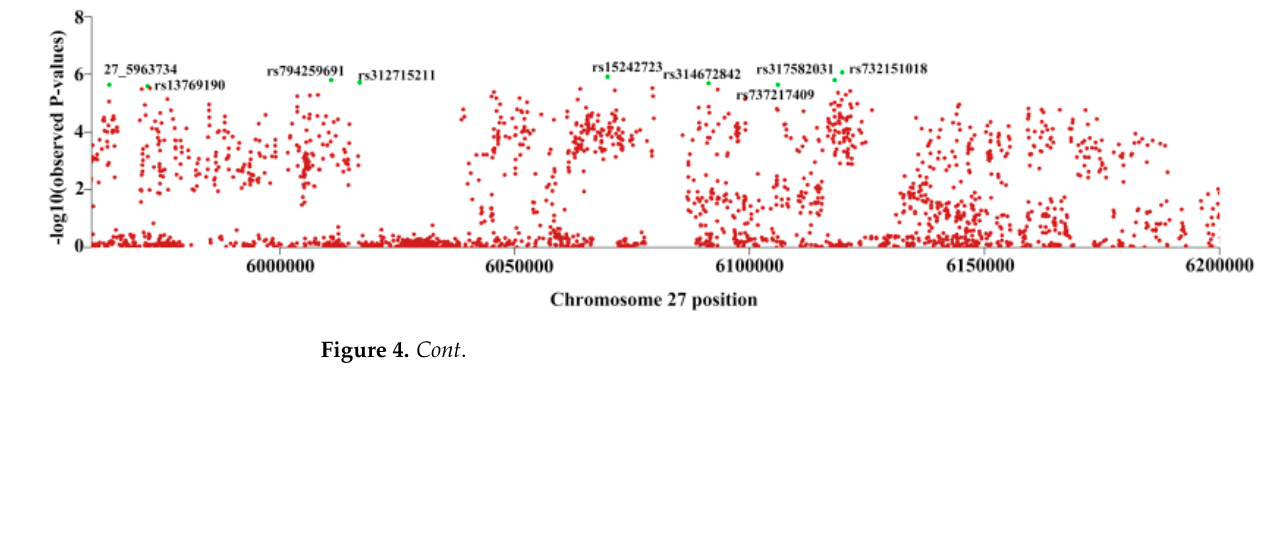
Figure 4. Locations of the candidate regions F ST and π . ( A ) Localized genome − wide association study (GWAS) and F ST . Green represents significant SNPs located by GWAS (Chr27: 5,963,734 −